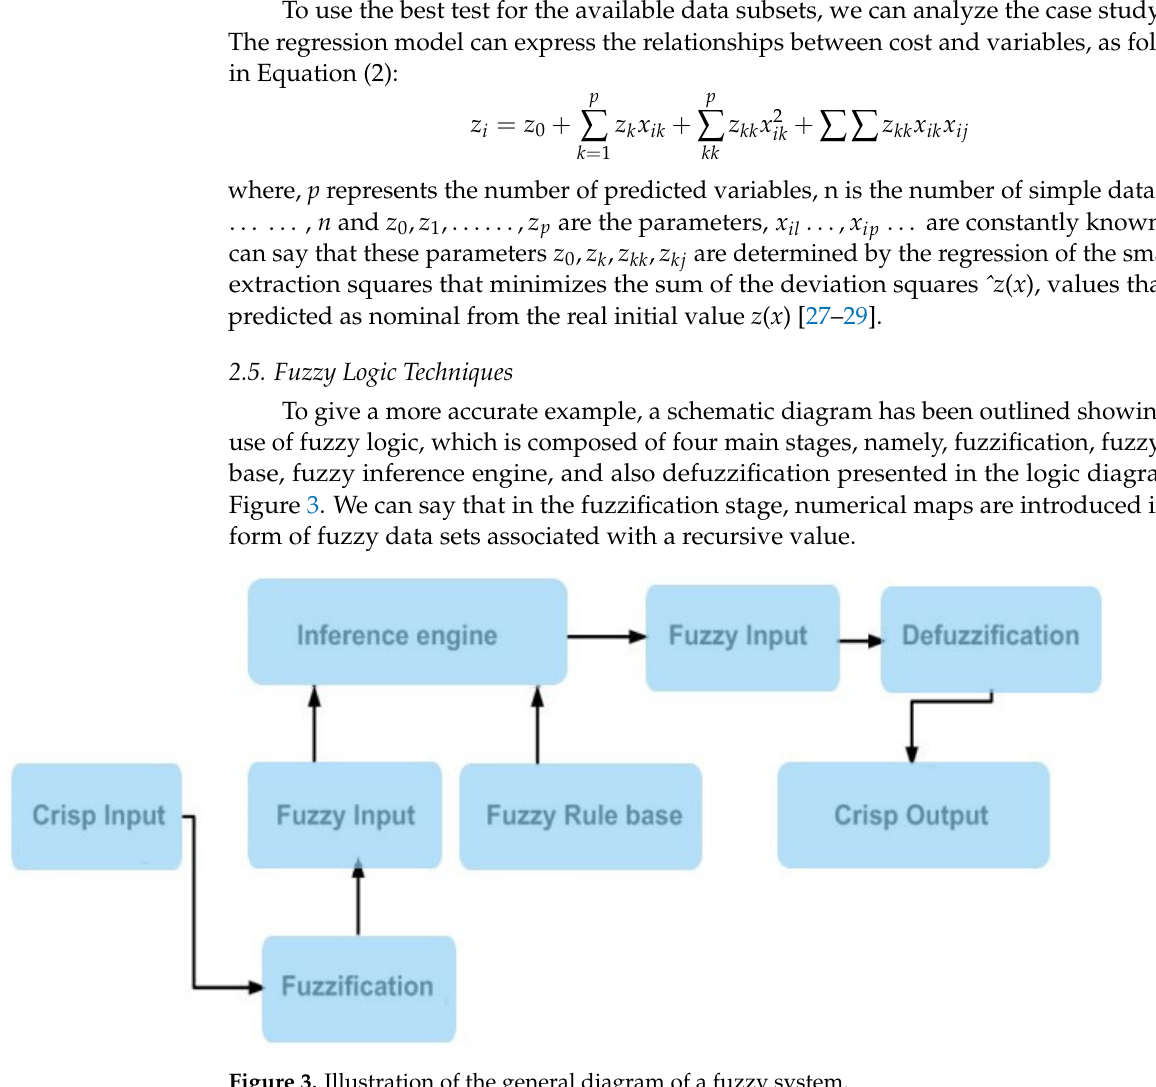
Figure 3. Illustration of the general diagram of a fuzzy system.